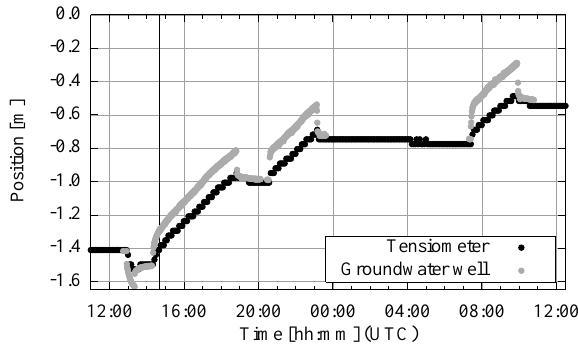
Figure 2. During the experiment with two distinct phases (initial drainage and multistep imbibition – separated by the vertical line), the position of the groundwater table was measured manually in the groundwater well and automatically with the tensiometer (Fig. 1). The difference between them is proportional to the driving force of water flow in the gravel